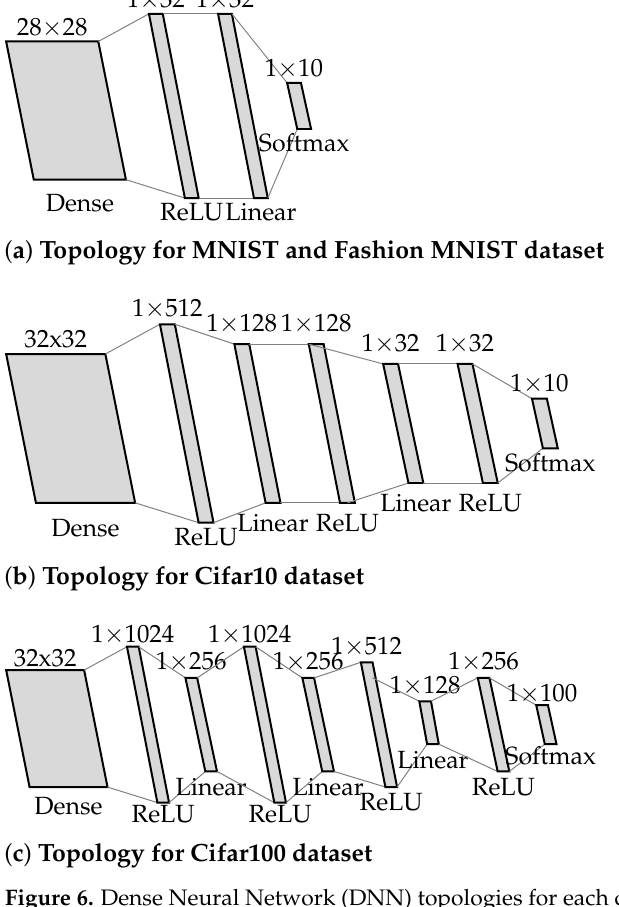
Figure 6. Dense Neural Network (DNN) topologies for each dataset: ( a ) Topology for MNIST and Fashion MNIST dataset, ( b ) Topology for Cifar10 dataset, ( c ) Topology for Cifar100 dataset.